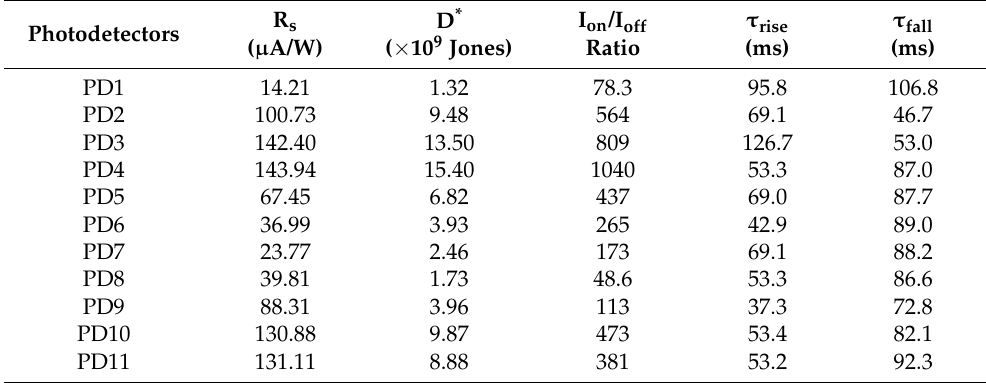
Figure 3. The photoelectric performance of the devices. ( a ) Scheme of the configuration and ( b ) the energy-band diagram of the ZnO QD/(PEA) 2 PBI 4 nanosheet photodetector. I-V characteristics of the devices ( c ) in the dark (I off ) and ( d ) under illumination (I on ) of 500 nm UV light (1.97 mW cm − 2 ). ( e ) The I on and I on /I off ratio of each device. ( f ) Responsivity (R s ) and normalized detectivity (D *) of each device with different contents of ZnO QDs. Table 2. Summary of the Rs, D * , I on /I off ratio, τ rise , and τ fall of each photodetector at 10 V bias voltage and under 500 nm light illumination.